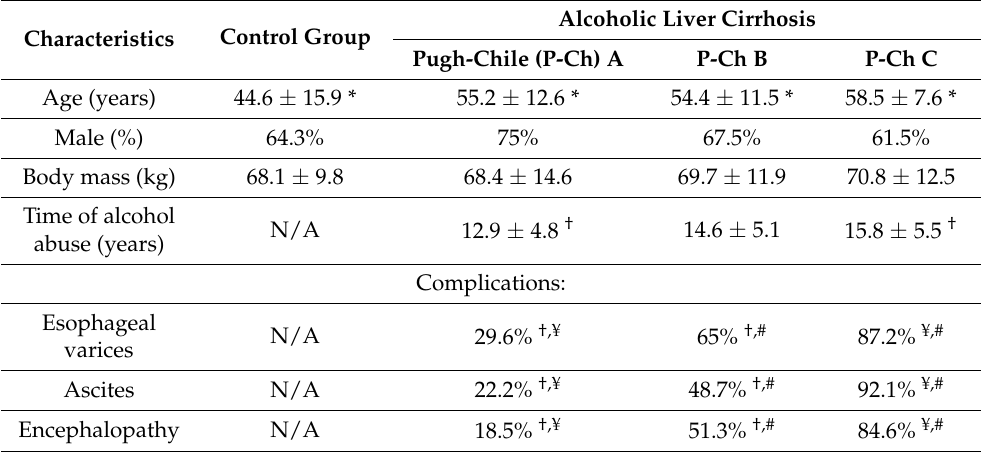
Table 1. Demographic and clinical characteristics of the study and control groups (mean ± SD).